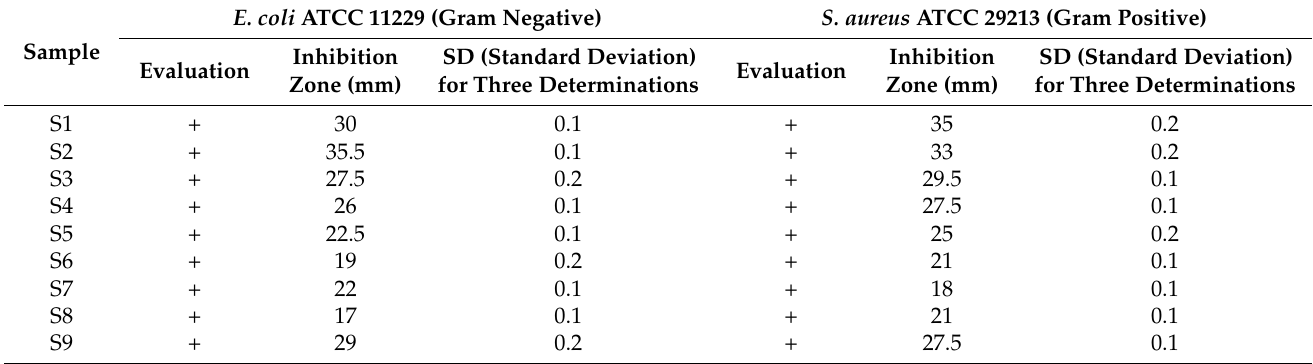
Table 3. The evaluation of the antimicrobial activity of the citrate-salecan samples.